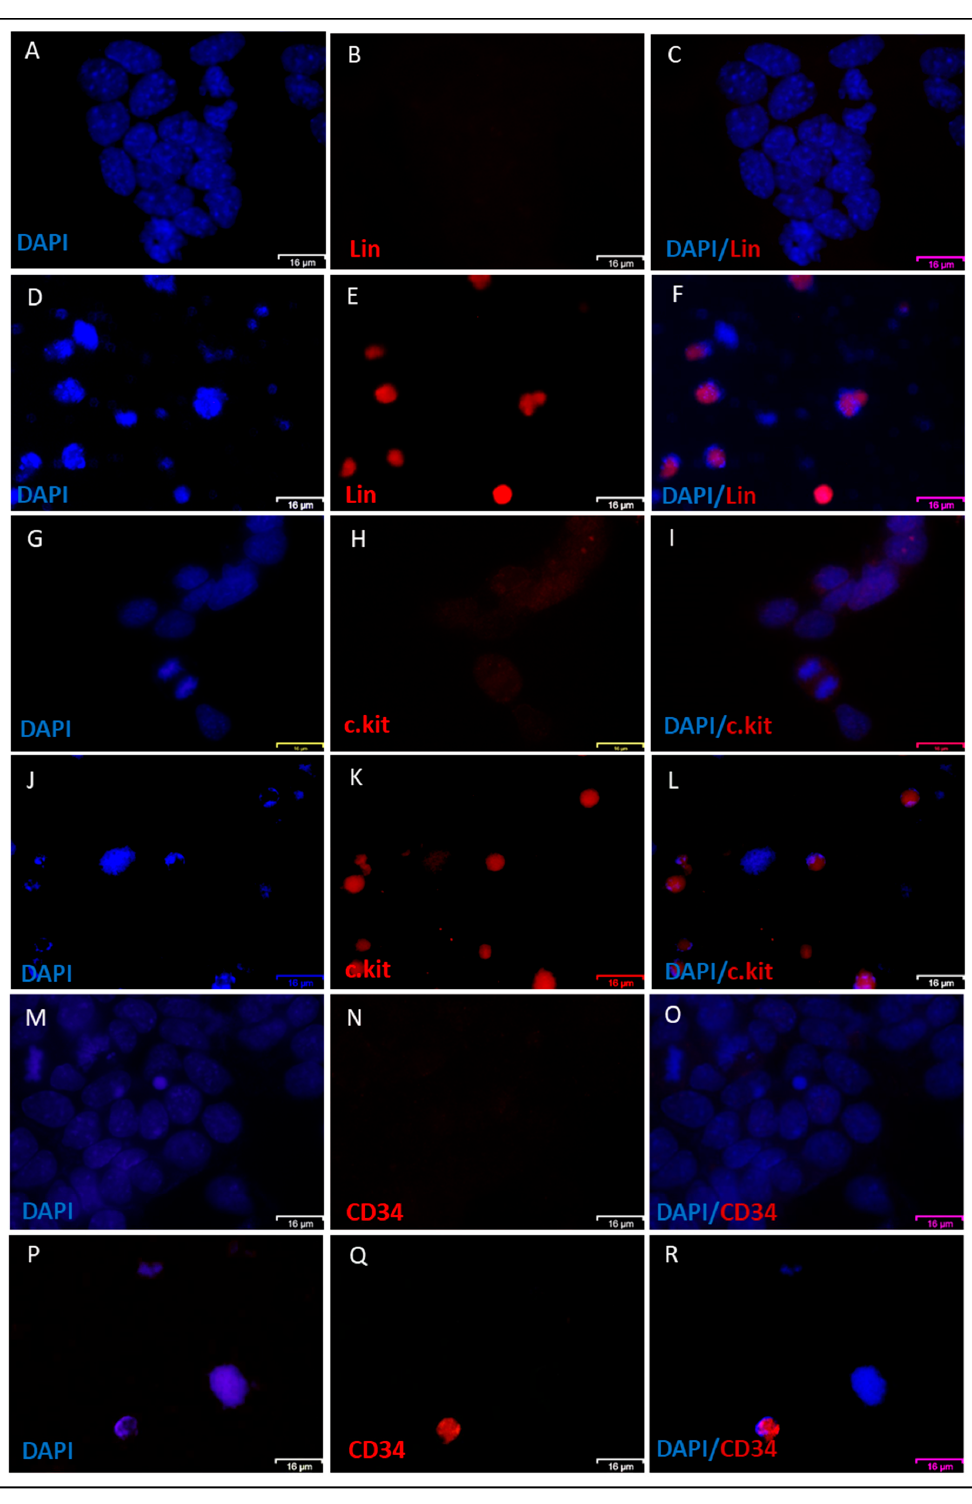
Figure 3. Immunofluorescence staining of NACs. ( A – F ) Immunofluorescence staining showing both adherent CSCcmBT549 cells ( A – C ) and floating cells ( D – F ) stained for lineage markers. ( G – L ) CD34 immunofluorescence staining showing both adherent CSCcmBT549 cells ( G –I) and floating cells ( J – L ). ( M – R ) c-kit immunofluorescence staining showing both adherent CSCcmBT549 cells ( M – O ) and floating cells ( P – R ). Scale bars represent 16 µ